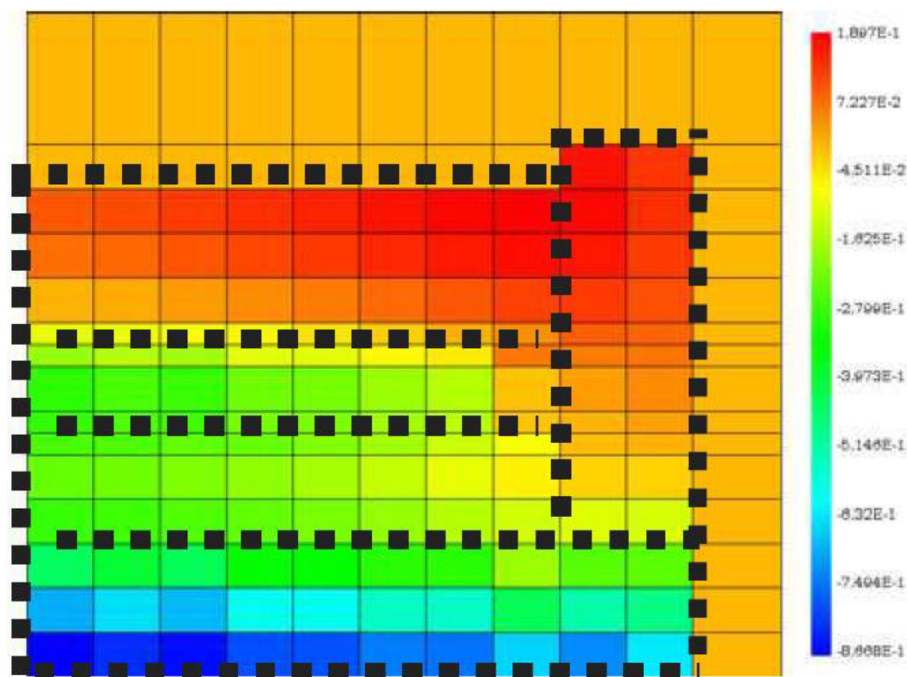
Fig. 6. ASTRID reactor (cid:1) Fissile +fertile partition into 132 regions (cid:1) Sensitivity of the fi ssion source distribution to the 238 U capture